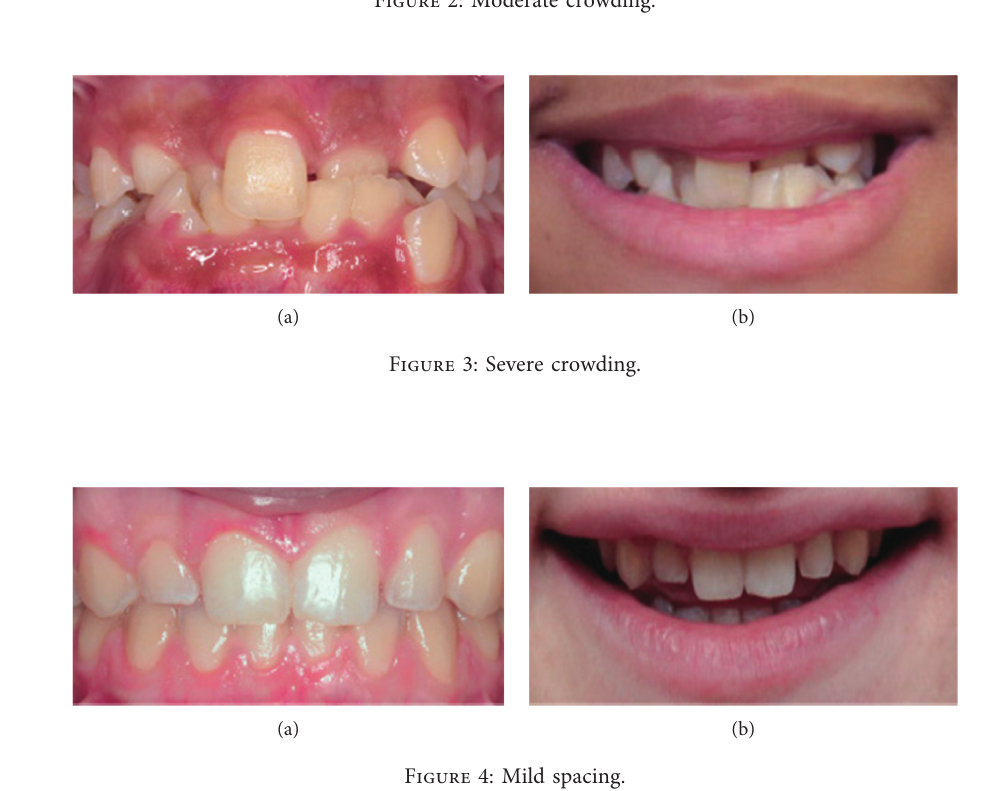
Figure 2: Moderate crowding.